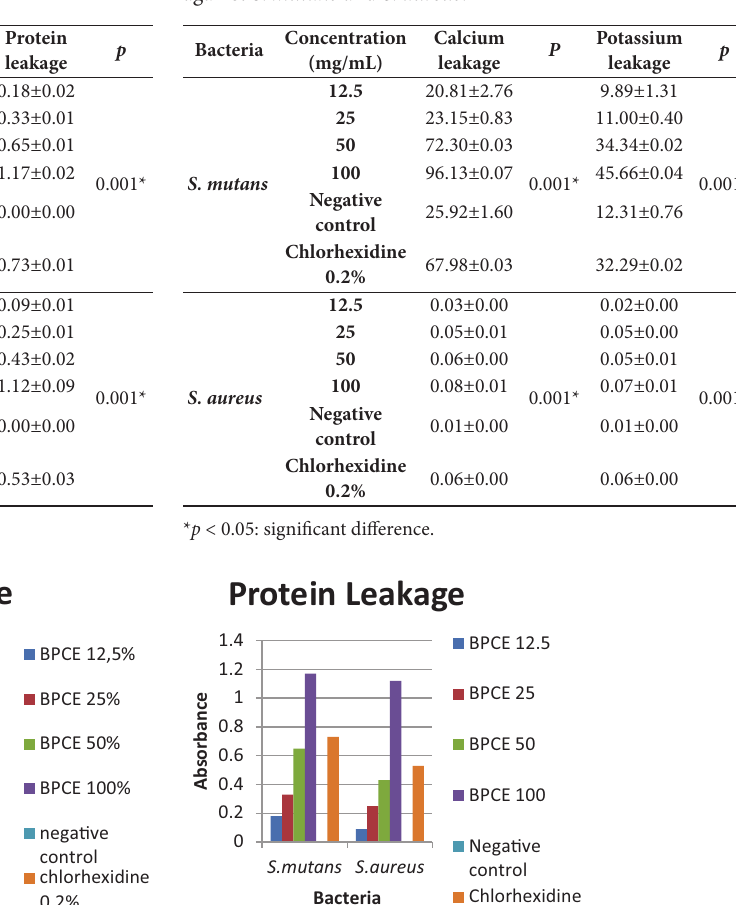
Table 2. Membrane intracellular (DNA and Protein) leakage of Medan BPCE against S . mutans and S. aureus .